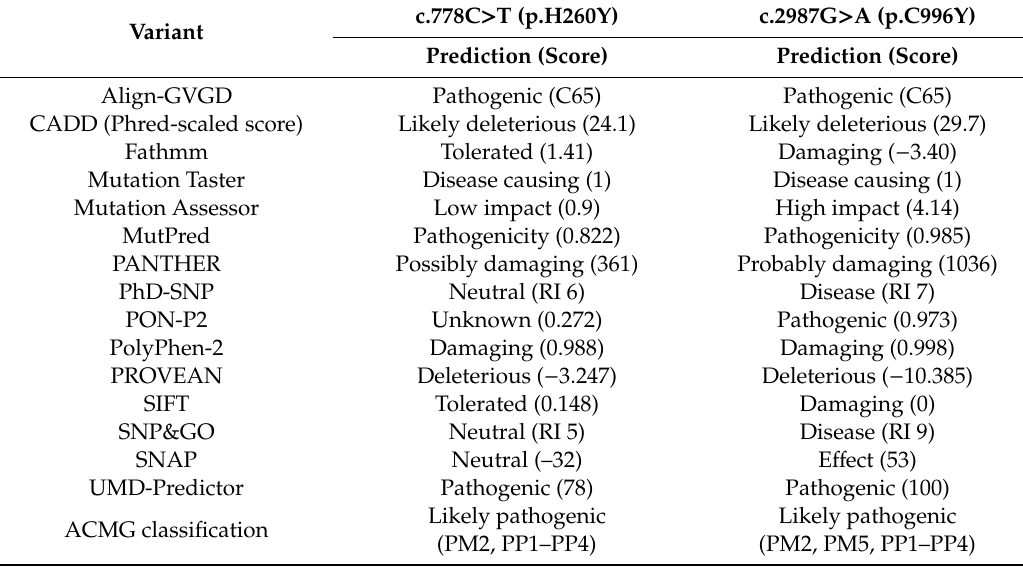
Table 2. In silico predicted e ff ects of the two candidate missense variants c.778C > T and c.2987G > A in the LAMA2